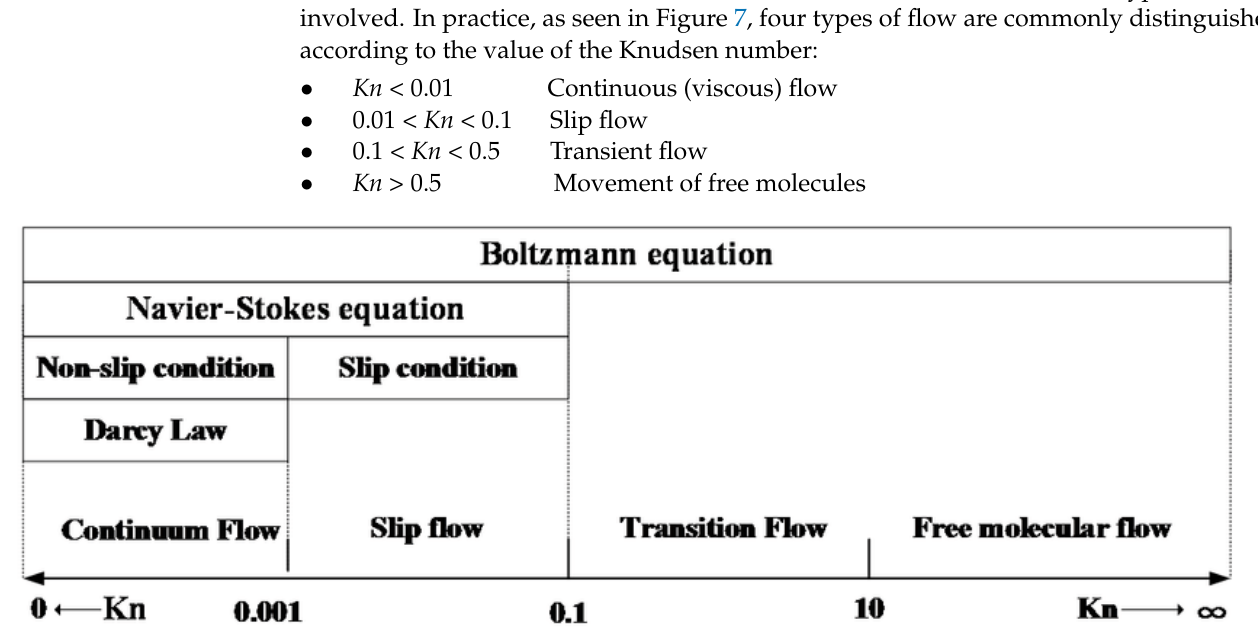
Figure 7. Flow regimes as a function of Knudsen number.